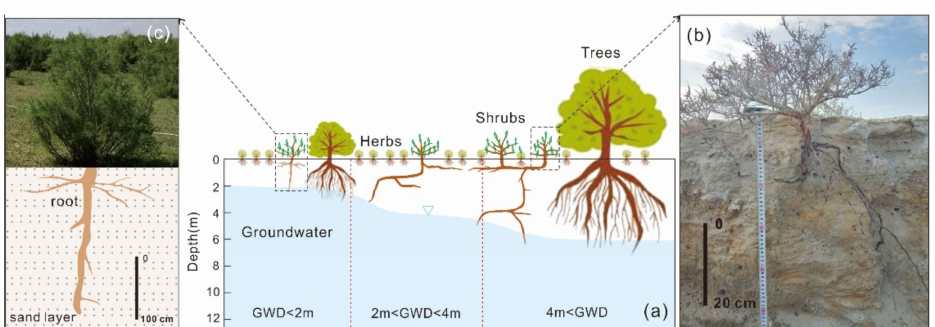
Figure 12. ( a ) Sketch of root distribution in the profiles of different groundwater depth in Shiyang River Basin; ( b ) Reaumuria soongorica ; ( c ) Tamarix